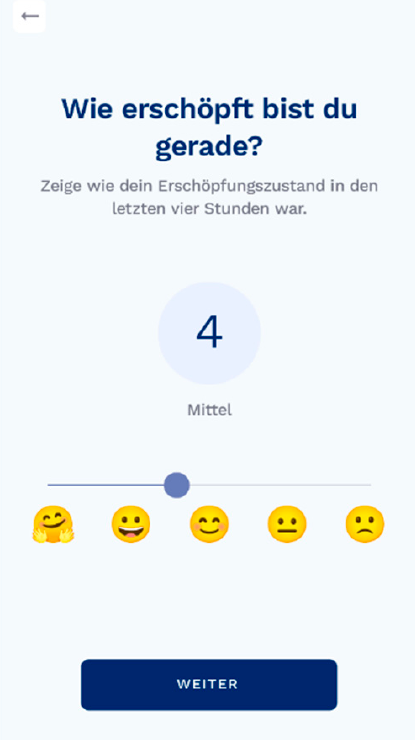
Figure 1. The VAS implemented in the Fimo health app.